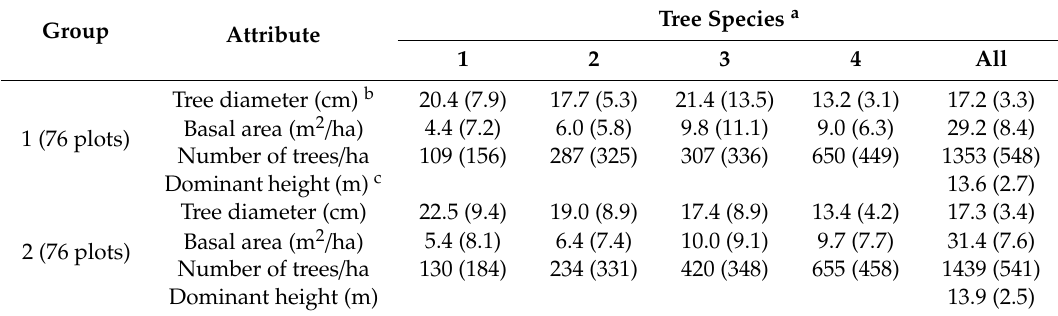
Table 1. Means (and standard deviations) of stand attributes for each species, by group. Group